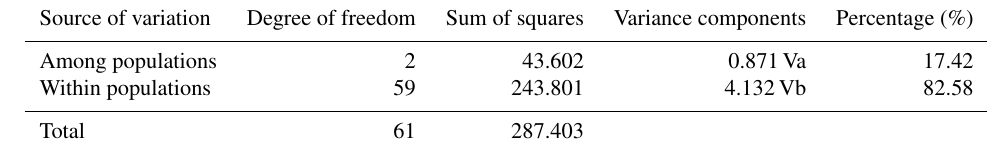
Table 3. AMOVA analysis in three native Turkish cattle breeds.